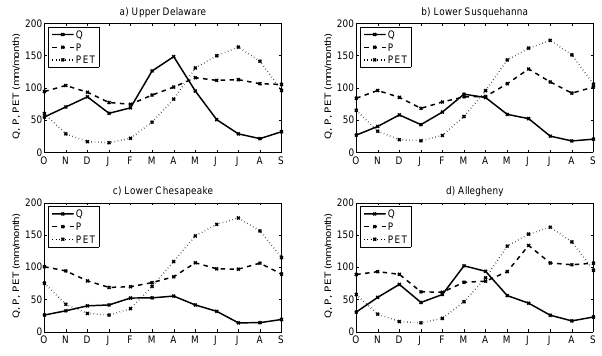
Fig. 8. Average monthly values of streamflow, precipitation and potential evapotranspiration of a sample catchment in (a) Upper Delaware, (b) Lower Susquehanna, (c) Lower Chesapeake, and (d) Allegheny